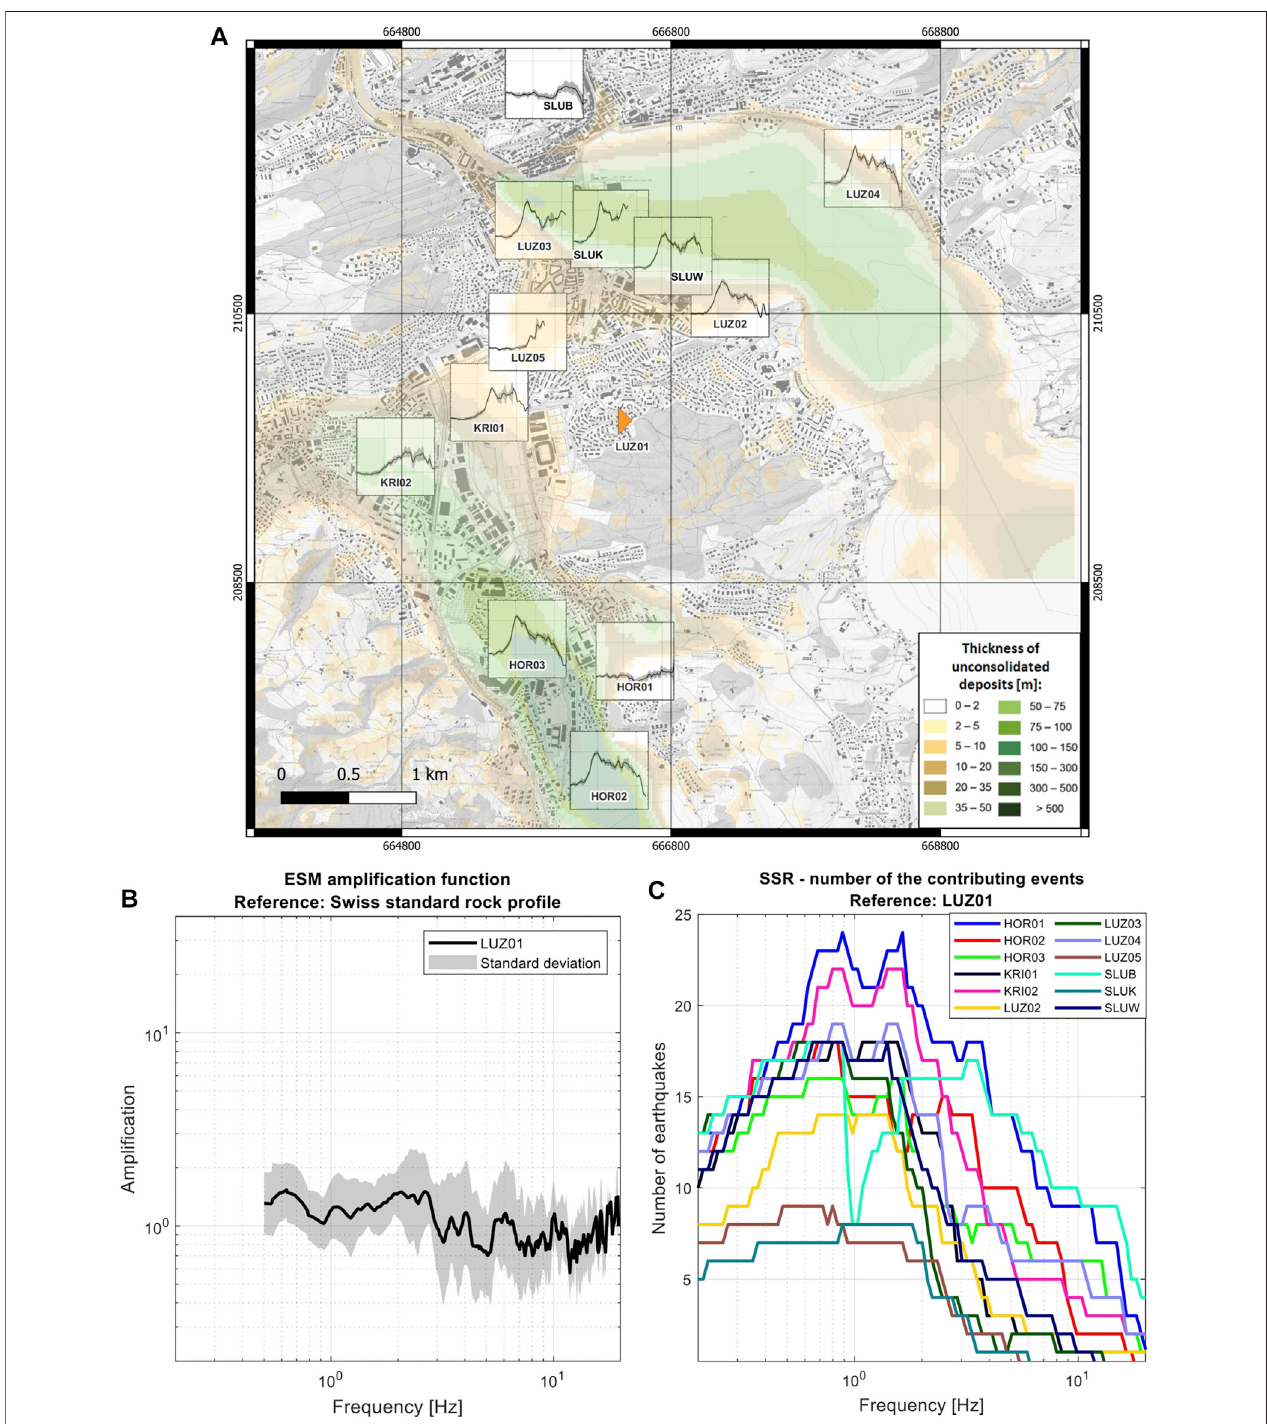
FIGURE5|(A) Ampli fi cationfunctions(horizontalcomponent)forstationslocatedintheLucerneareausingtheSSRmethodreferencedtotherockstationLUZ01. The center of each plot corresponds to the station location. All plots have the same scale as the plot in (B) . In the background, the thickness of the unconsolidated depositsmapisshown. (B) ESMampli fi cationfunction(Edwardsetal.,2013)forrockstationLUZ01. (C) Numberofcontributingeventsforeachfrequencyforallsitesfor the SSR method.